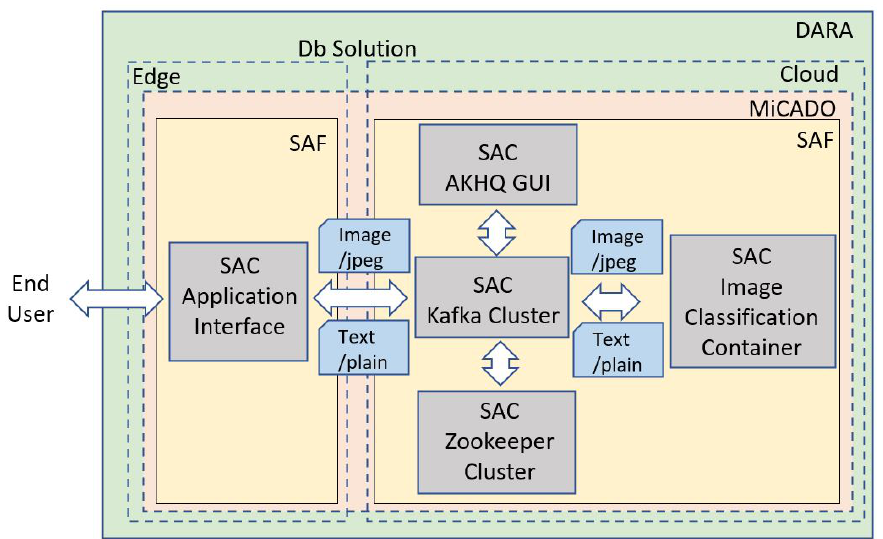
Figure 4. The graphical representation of the ML Image Classification use case indicating the SAC (marked in grey) and SAF (marked in orange) components, the DARA (marked in green), responsibil- ities of MiCADO (marked in red), and the stream payloads with MIME types (marked in